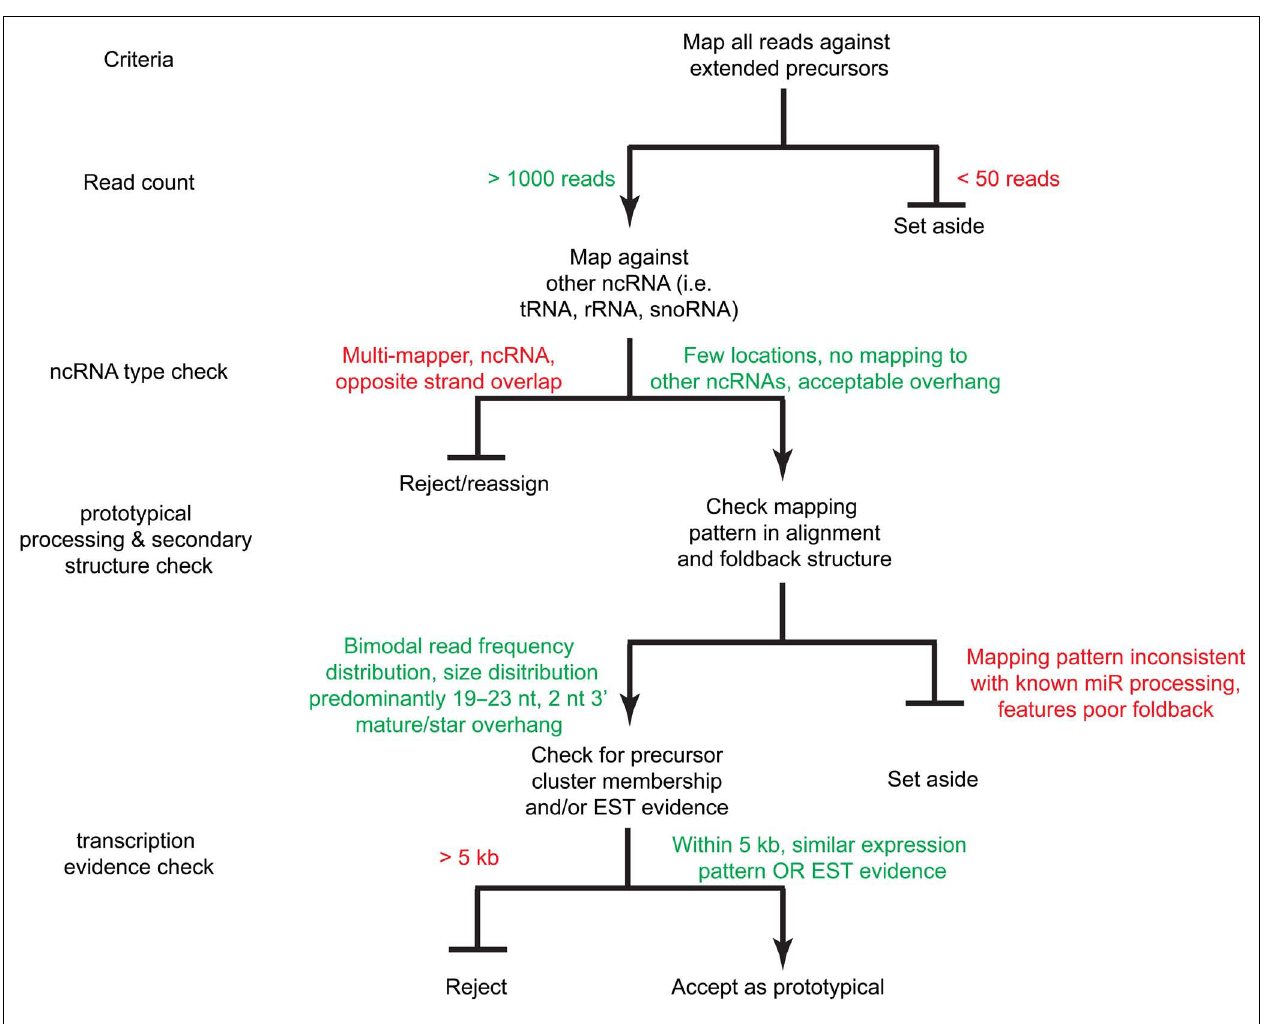
FIGURE 4 |A decision tree for miRNA acceptance criteria. Sequence reads are mapped against the extended precursors as well as other ncRNA databases (i.e., tRNAs, snoRNAs, rRNAs, etc.). Reads with sufficient read